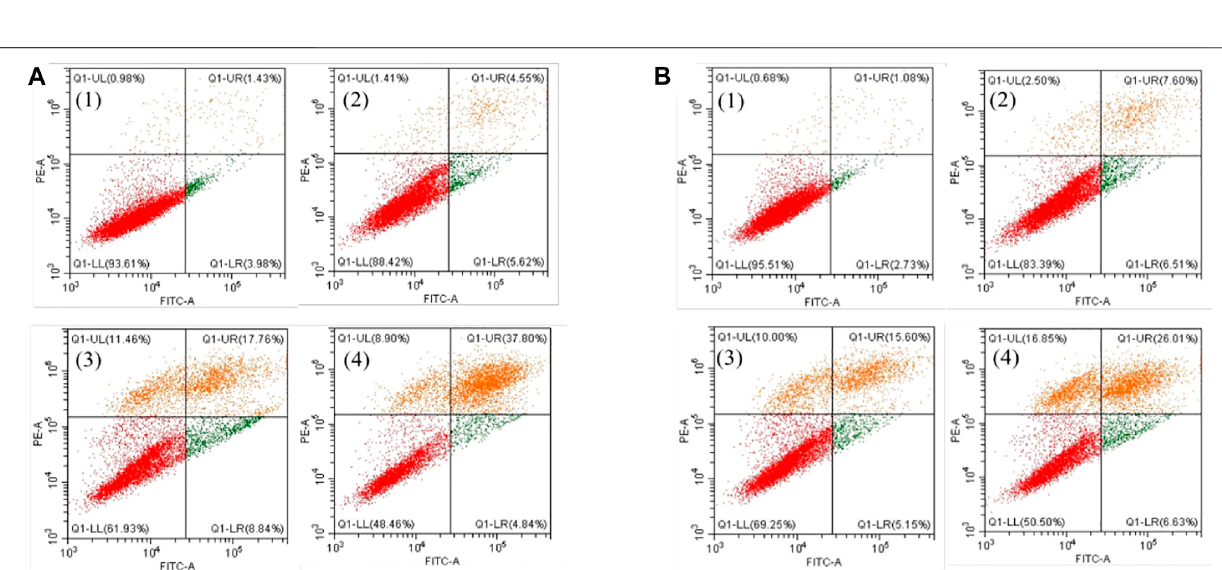
Frontiers in Chemistry |